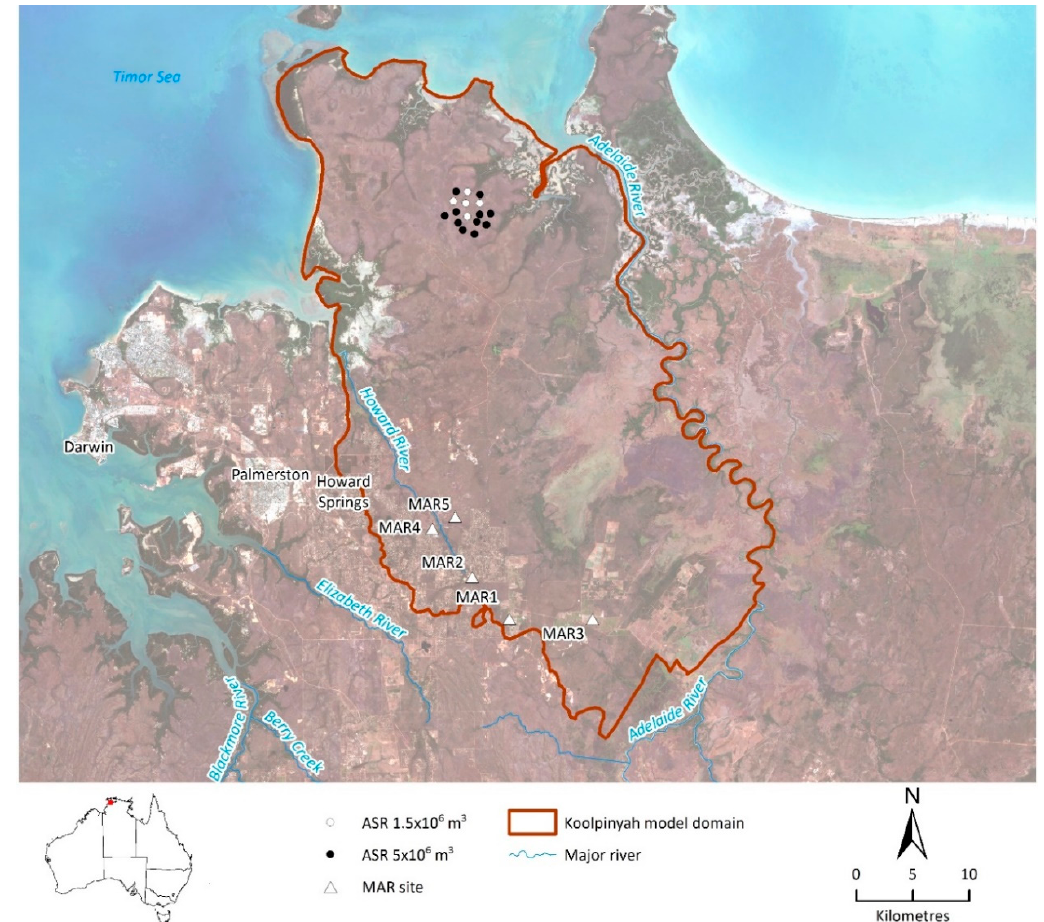
Figure 2. Location of modelling scenarios: Infiltration basin and well injection scenarios where aquifer is unconfined at MAR1-5; ASR Water bank scenarios where aquifer is confined in the northern section. White and black circles indicate a prospective location for a strategic ASR water bank (1.5 and 5 Mm 3 /year). MAR scenarios are described in detail in Table 1.